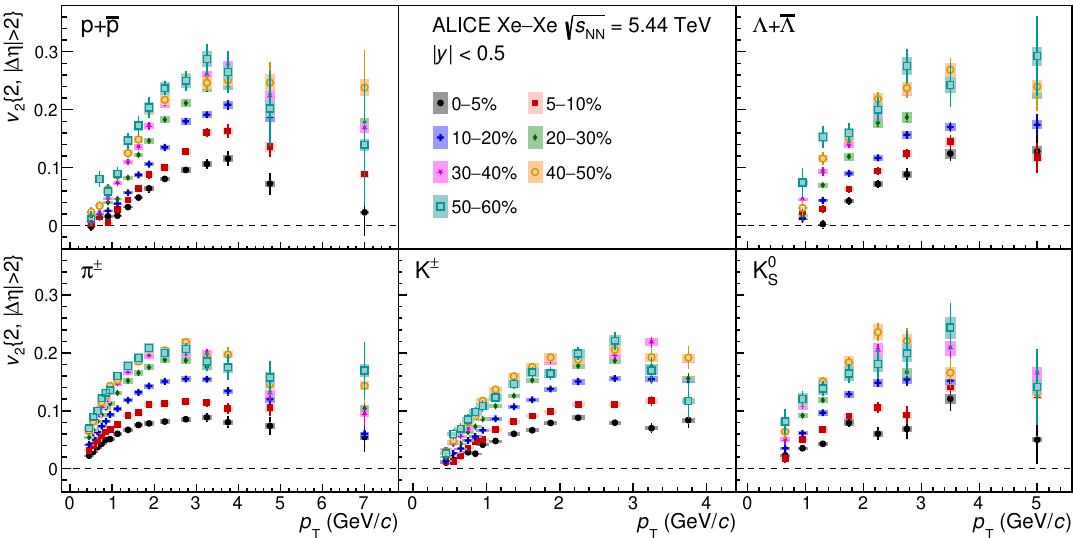
Figure 2. Centrality dependence of v 2 ( p T ) for π ± , K ± , p+ p , K 0 statistical (systematic)